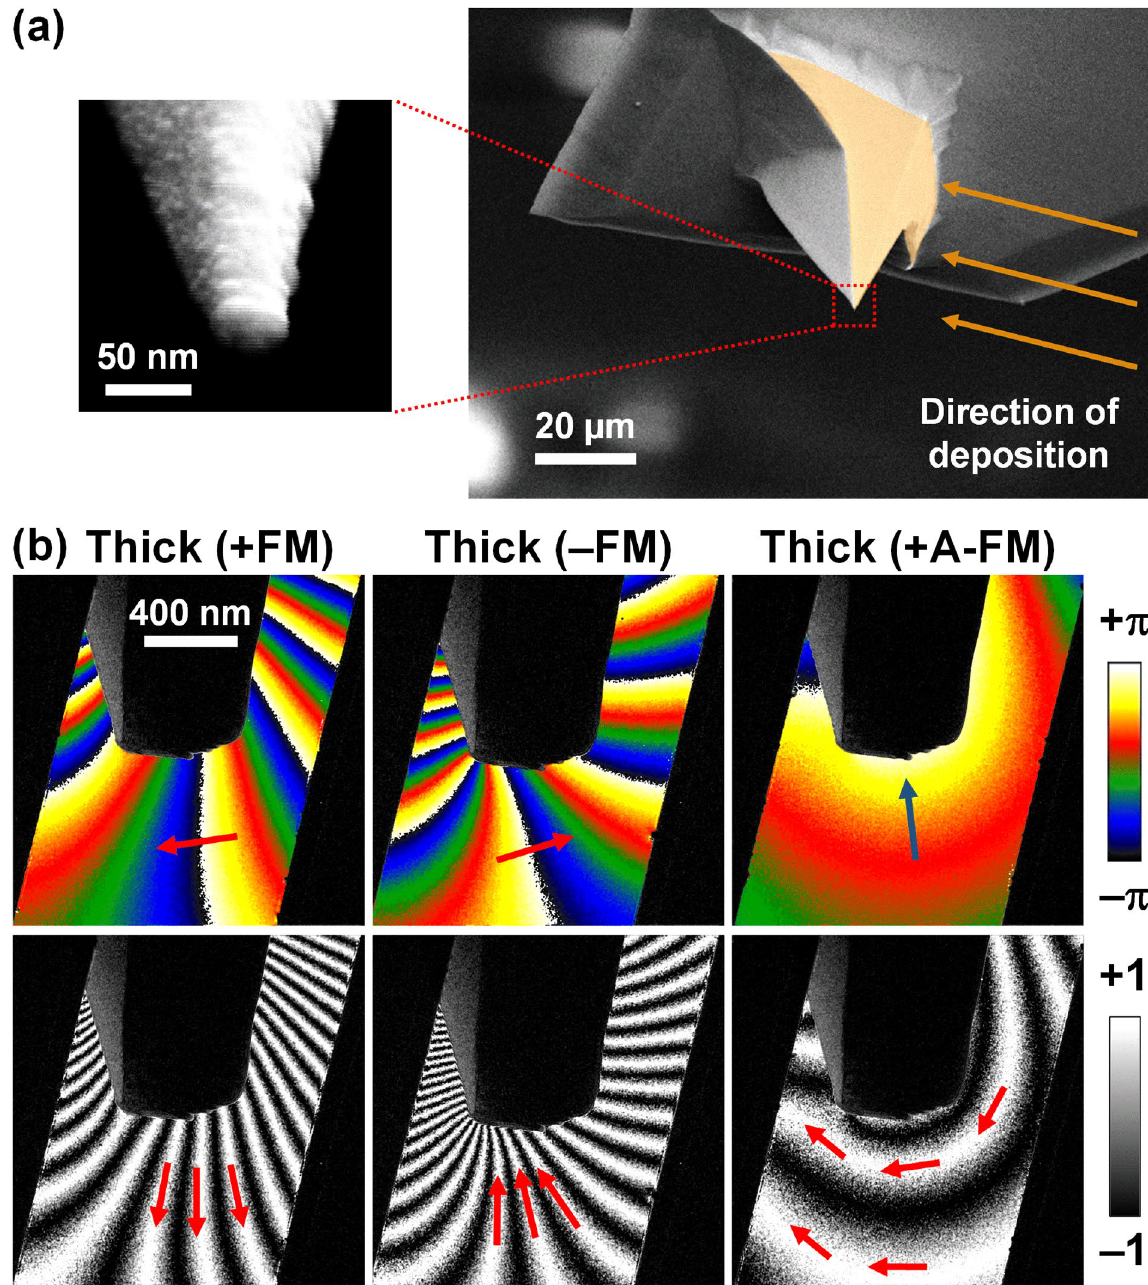
Figure 2. Scanning electron micrograph and electron holography images of ML-MFM probes. ( a ) SEM images illustrating the deposition of multi-layer coating on a Si probe, final curvature radius is ~20 nm and ~35 nm for the thin and thick ML-MFM probes, respectively. ( b ) EH images taken near the apex of the thick ML-MFM probe. Colour images correspond to the magnetic phase shift, while black and white images represent the configuration of the magnetic flux due to the stray field. Arrows in the phase shift and magnetic flux images indicate the direction of the phase shift gradient and magnetic flux,